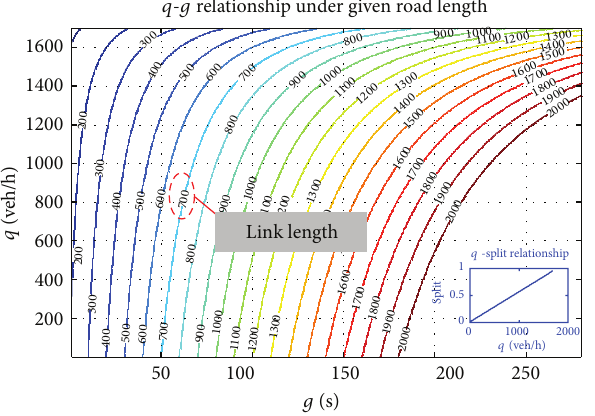
Figure 5: Critical 𝑞 - 𝑔 relationship under different link length.